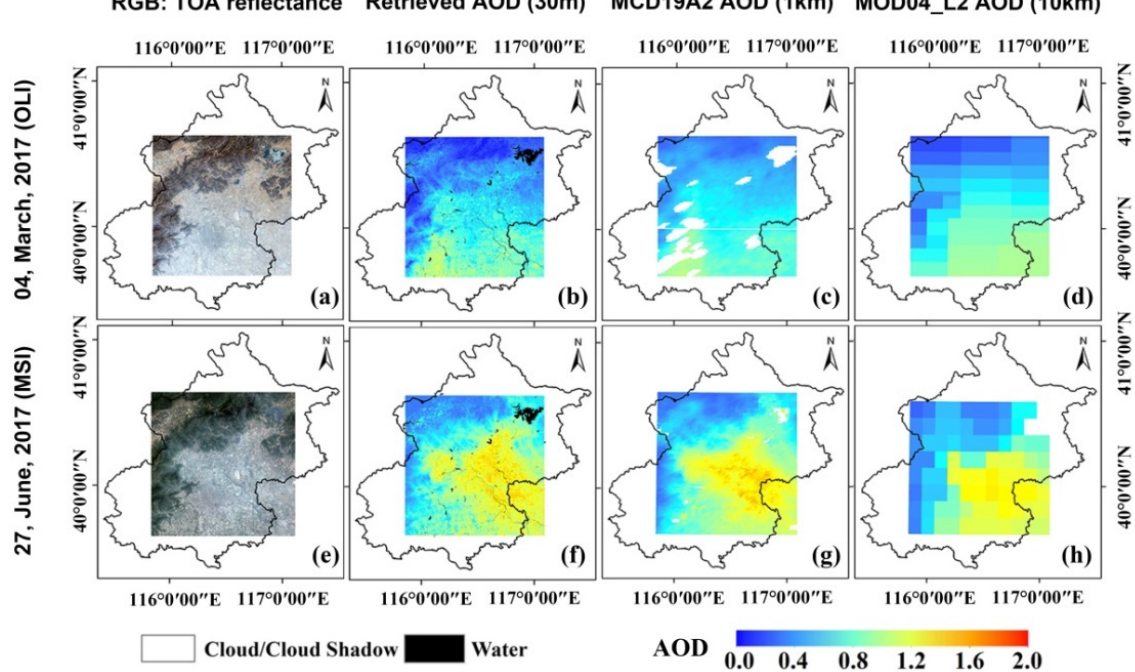
Figure 11. Color composite image (red-green-blue) of Landsat-8 and Sentinel-2, and corresponding spatial distribution of ( a , e ) retrieved AOD in 30 m ( b , f ), MCD19A2 AOD in 1 km ( c , g ) MOD04_L2 DB & DT AOD in 10 km ( d , h